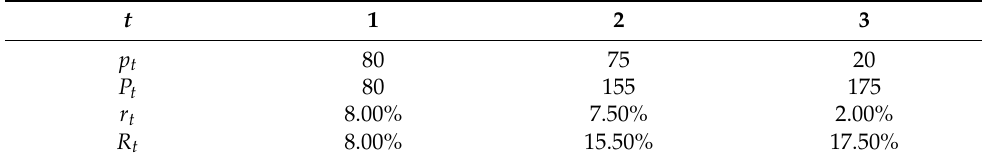
Table 2. Portfolio ( EAD = 1000 ) performance in 3 years ( T = 3 ). t 1 2 3 p